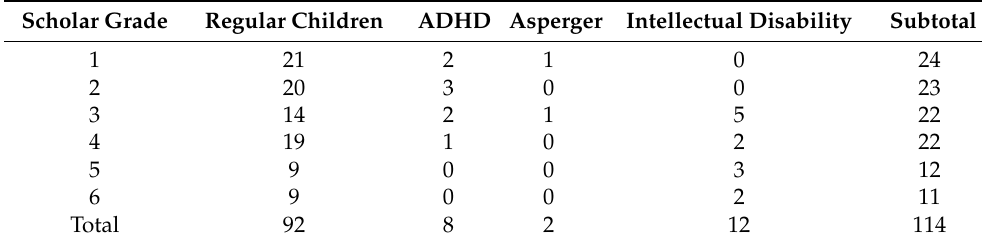
Table 1. Total children in elementary education order by scholar